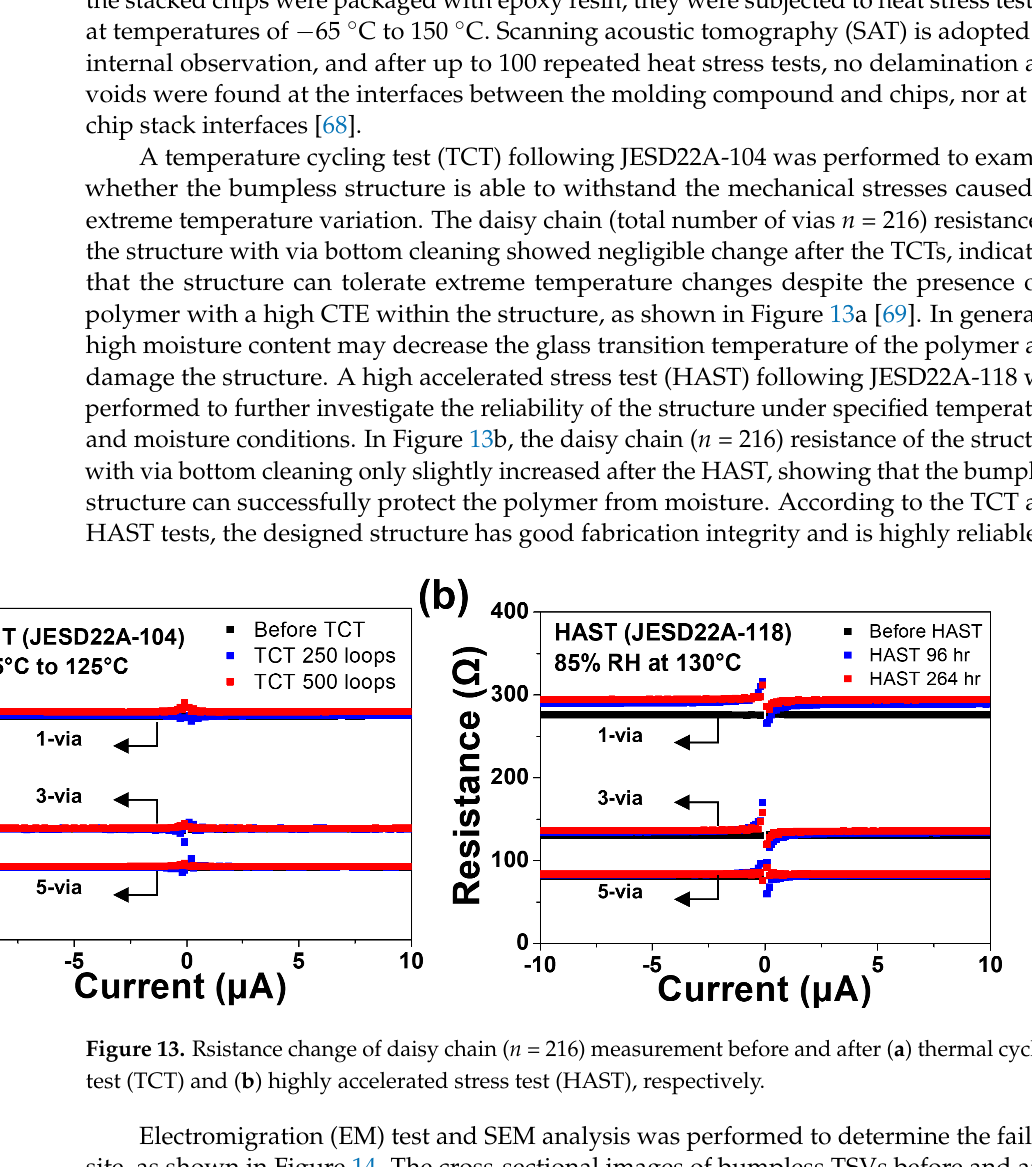
Figure 14. Cross-sectional SEM images of bumpless TSV interconnects before and after electromi- gration test (EM) ( left ). A comparison of electromigration characteristics between bumpless TSV structure and the conventional TSV with microbump ( right ) [71].